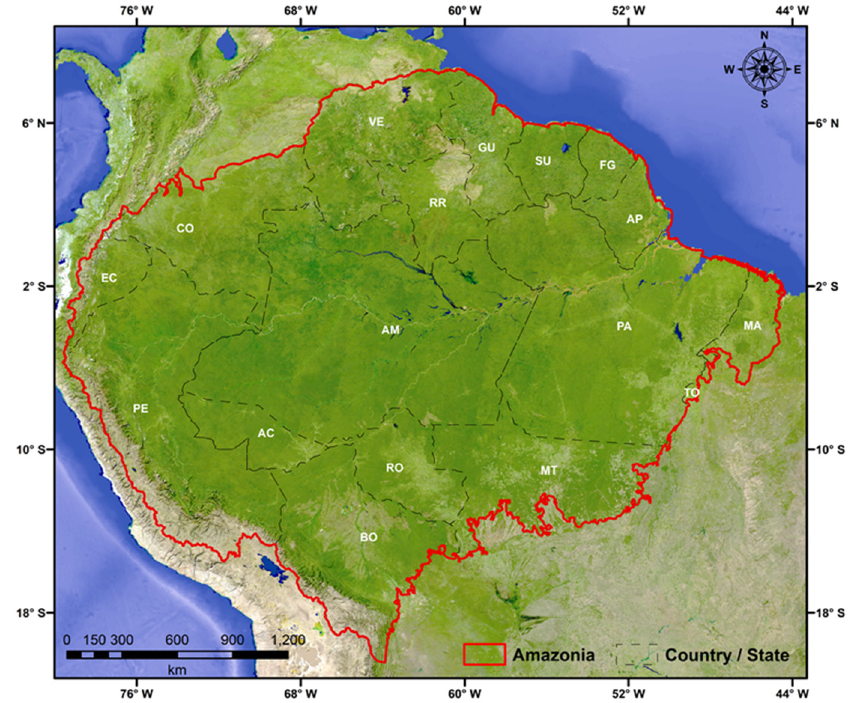
Figure 1. Spatial location of Amazonia and the 17 countries/states considered in this study. The base map is a Moderate Resolution Imaging Spectroradiometer (MODIS) MOD09A1 product color composite R6G2B1 for the year 2019. BO = Bolivia, CO = Colombia, EC = Ecuador, FG = French Guiana, GU = Guiana, PE = Peru, SU = Suriname, VE = Venezuela, AC = Acre, AM = Amazonas, AP = Amapá, MA = Maranhão, MT = Mato Grosso, RO = Rondônia, RR = Roraima, PA = Pará and TO = Tocantins.